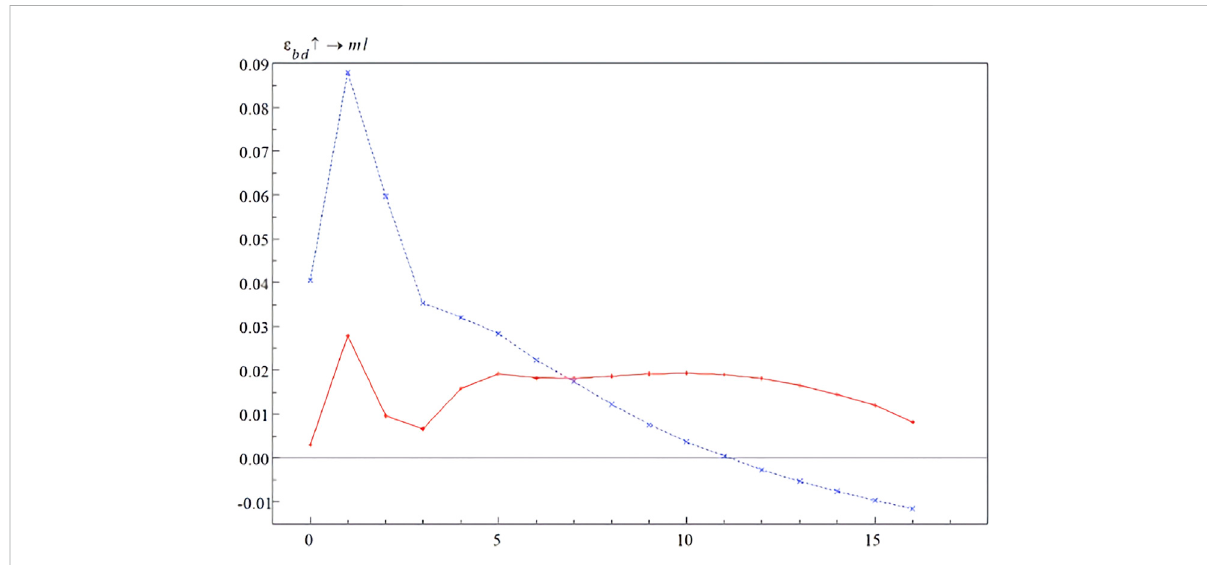
FIGURE 5 Time-point impulse response diagram. Note: The red line represents time point 1 (December 2019) and the blue line represents time point 2 (April